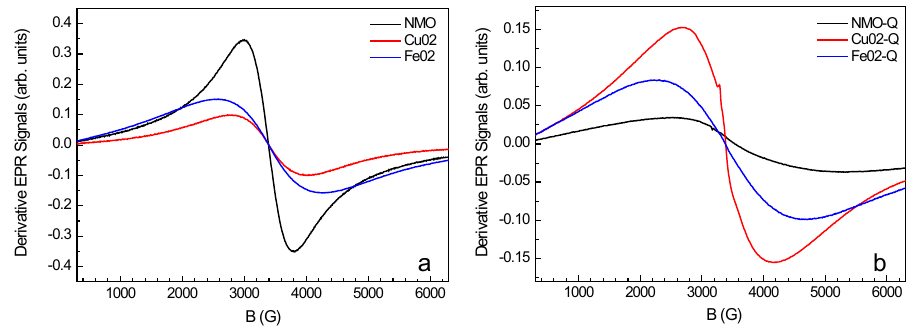
Figure 4. Room-temperature EPR spectra for ( a ) slowly cooled and ( b ) quenched samples.